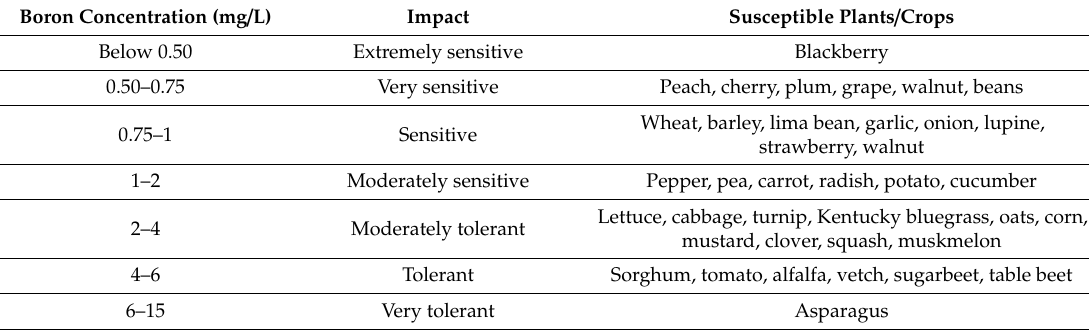
Table 4. Boron concentration impact on various classes of plants and